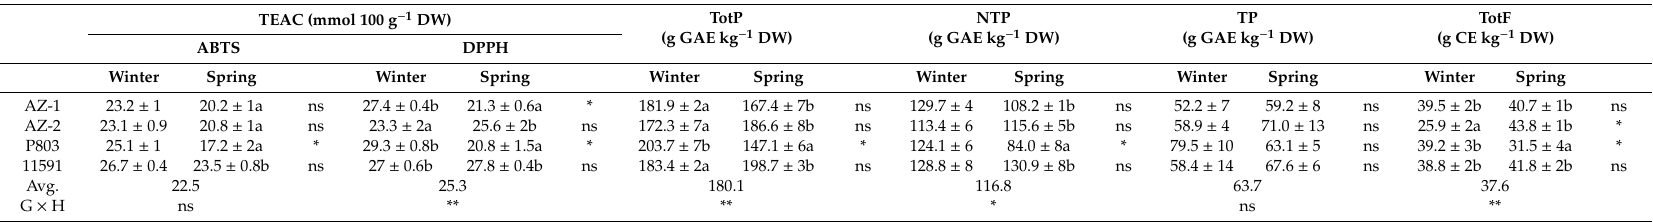
In the columns of each harvest (H) time (winter and spring), means followed by the same letter are not significantly di ff erent at p ≤ 0.05. In the rows, least significant di ff erences test indicates harvest time e ff ect on each examined accession of Parthenium argentatum . G × H: interaction between genotype and season of harvest. ns, not significant; ** p ≤ 0.001, * p ≤ 0.05.